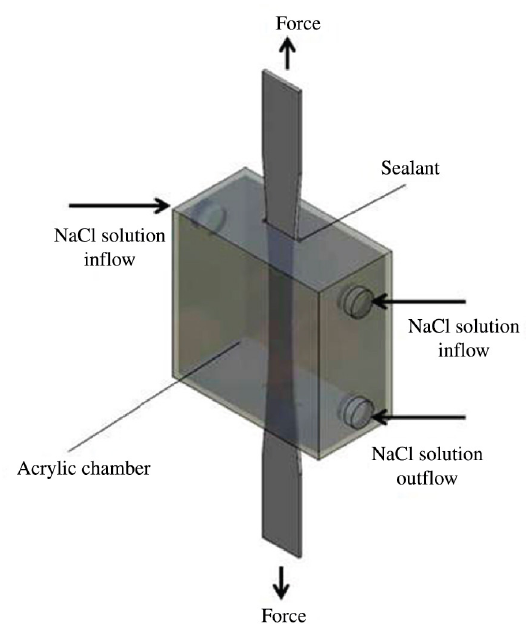
Figure 2. Schematic view of the experimental setup for corrosion fatigue tests.